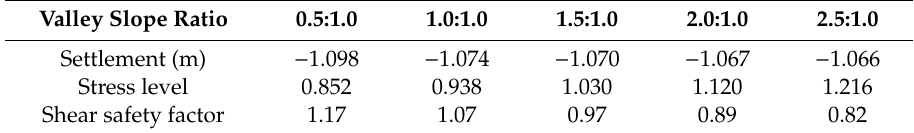
Figure 11. Relationship between stress level maximum of ACC and valley slope ratio. Table 3. Settlement, stress level, and shear safety factor of ACC with di ff erent valley slope